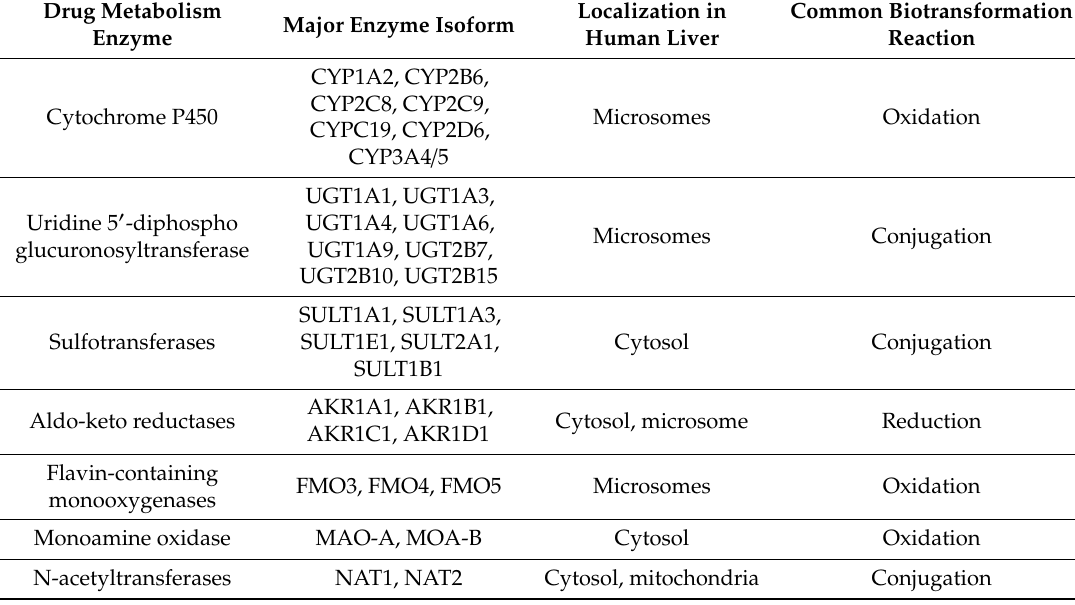
Table 2. Drug metabolism enzymes localization and commonly catalyzed biotransformation reaction in human liver